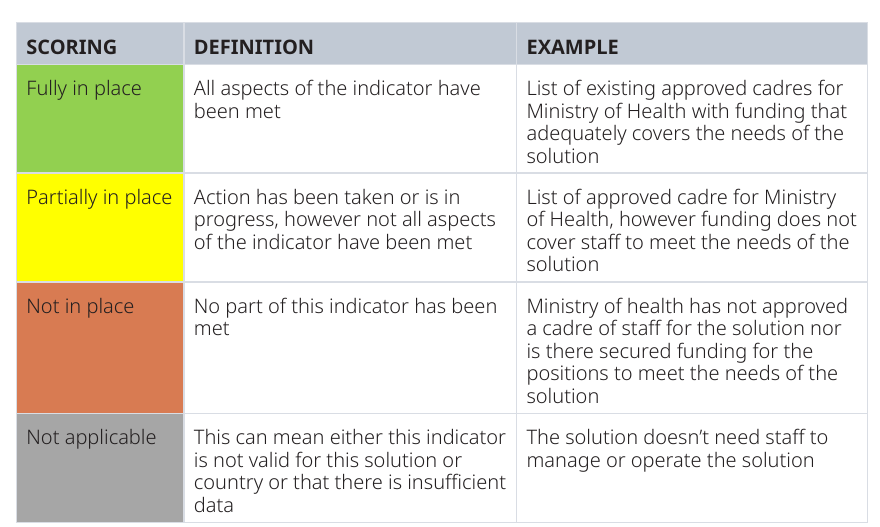
Table 1. TRA scoring